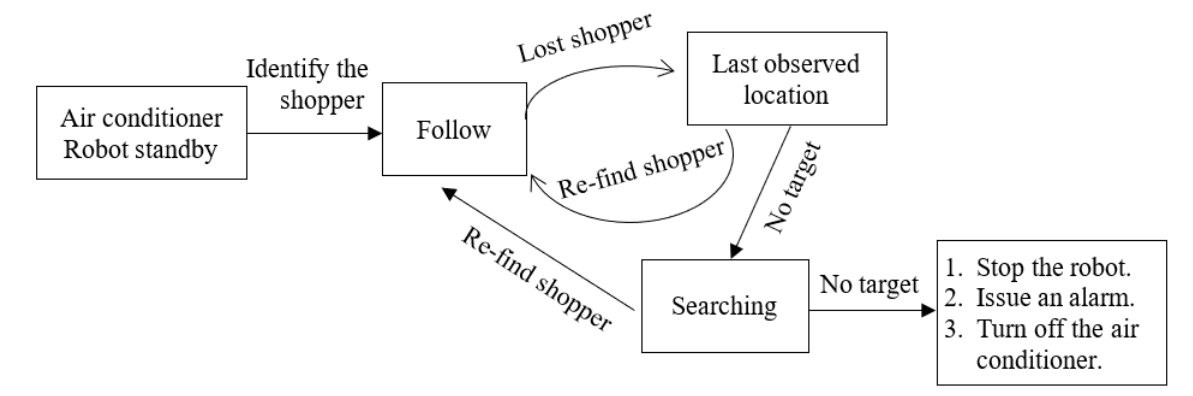
Figure 3. The diagram for the proposed shopper tracking system.